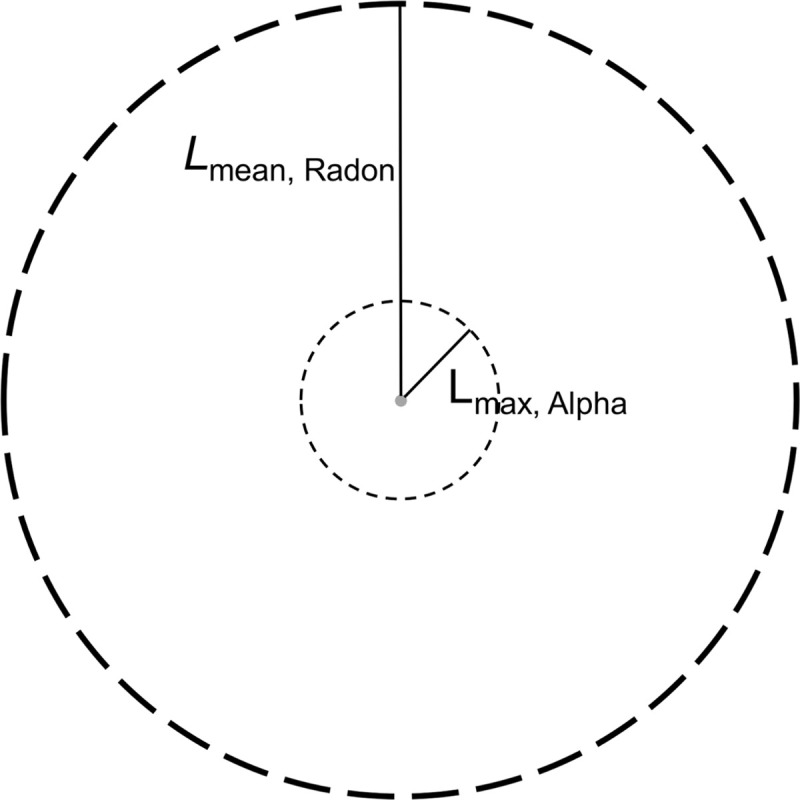
Illustration of the maximum distance alpha particles can travel in water (Lmax, Alpha = 100 μm) and estimated mean diffusion length of 220Rn in water (Lmean, Radon = 300–400 μm) relative to the CaCO3 microparticle size (5 μm in diameter).